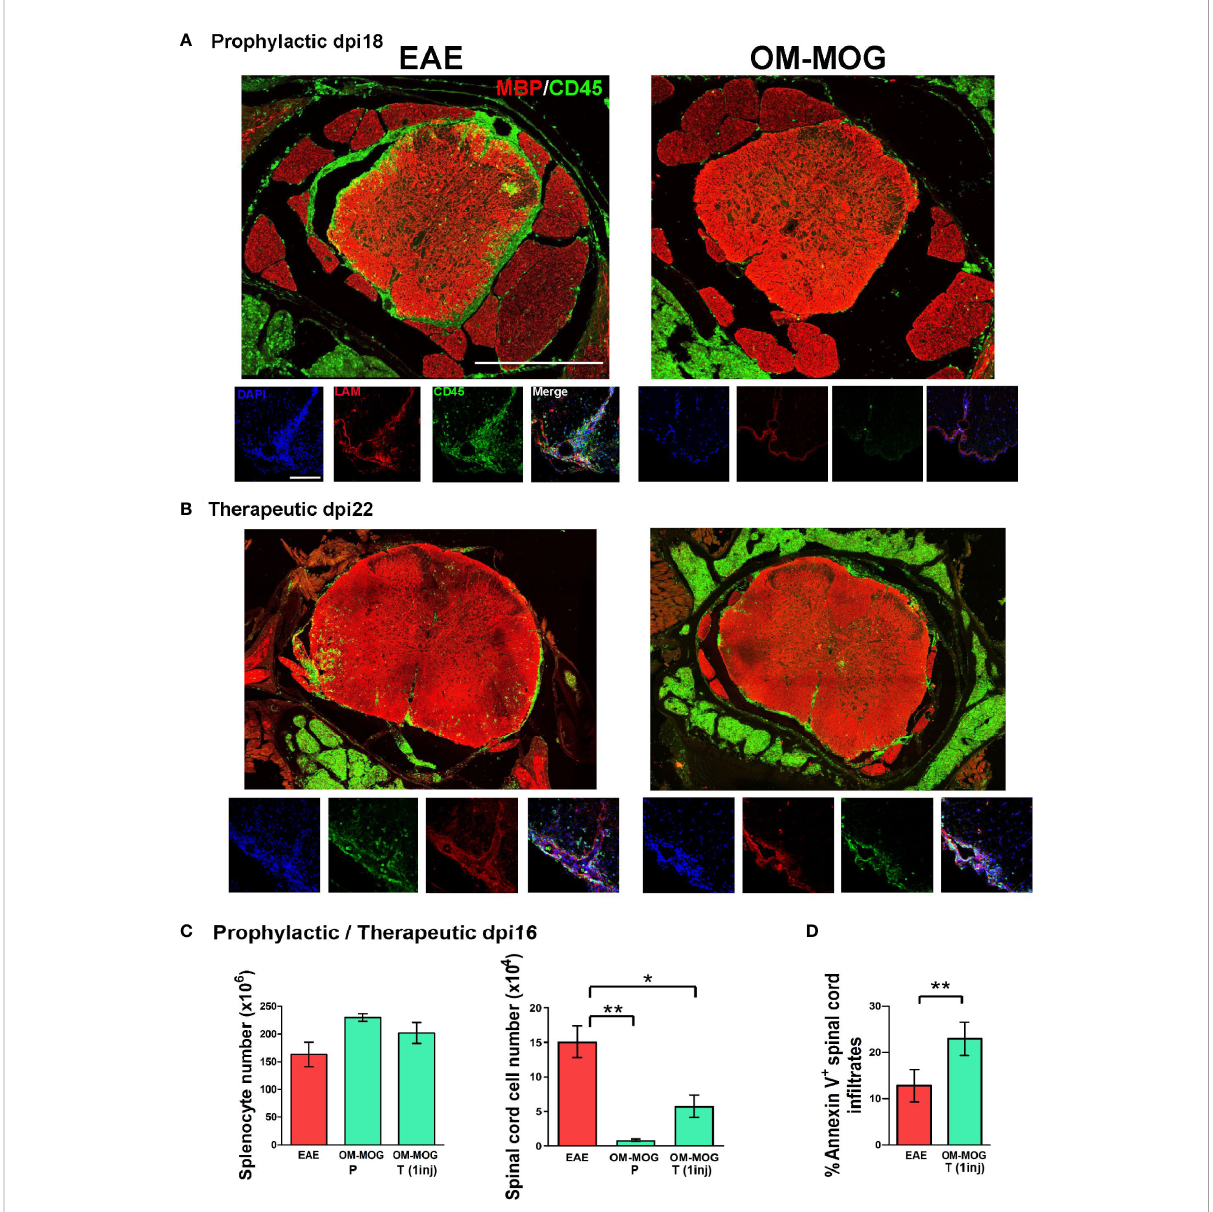
FIGURE 4 OM-MOG prevents and reverses immune cell in fi ltration and demyelinating lesions in the spinal cord during EAE. (A) Whole mount spinal cord sections with surrounding meninges and vertebrae prepared from EAE mice after short-term prophylactic administration of vehicle or OM-MOG (dpi 7, 11 and 14) at peak of disease in the EAE group (dpi 18), and immunostained with anti-MBP for myelin (red) and anti-CD45 for immune in fi ltrates (green) (low power photomicrographs), or anti-laminin for blood brain barrier (LAM; red), anti-CD45 (green) and DAPI (blue) (high power photomicrographs). Representative images from 1 of 3 mice/group. Scale bars 500 m M (upper low-power images) and 100 m M (lower high-power images). (B) Whole mount spinal cord sections prepared from mice with ongoing EAE (dpi 22) after therapeutic treatment with 4 injections of vehicle or OM-MOG starting at clinical score 2, and immunostained with anti-MBP for myelin (red) and anti-CD45 for immune in fi ltrates (green) (low power magni fi cation), or anti-laminin for blood brain barrier (LAM; red), anti-CD45 (green) and DAPI (blue) (high power magni fi cation). Representative images from 1 of 3 mice/group. (C) Total numbers of splenocytes and CNS-in fi ltrating mononuclear cells recovered from spinal cords of EAE mice at disease peak (dpi 16) after short-term prophylactic administration, as in A (OM-MOG P), or 24 h after 1 therapeutic injection of vehicle or OM-MOG (OM-MOG T, 1 inj) (n=8 for EAE and n=4 for OM-MOG). (D) Proportions of Annexin V + CNS- in fi ltrating mononuclear cells recovered from spinal cords of EAE mice at disease peak (dpi 14) 24 hours after 1 therapeutic injection of vehicle (EAE) or OM-MOG (OM-MOG T, 1 inj) (n=4-5/group). Data and statistical analysis are derived from one experiment in each case (A – C) or one representative of two experiments (D) . Statistical signi fi cance is shown after comparison to the vehicle (EAE) group using one-way ANOVA followed by Tukey ’ s post hoc test (C) , or Student ’ s t test (D) (*p ≤ 0.05, **p ≤